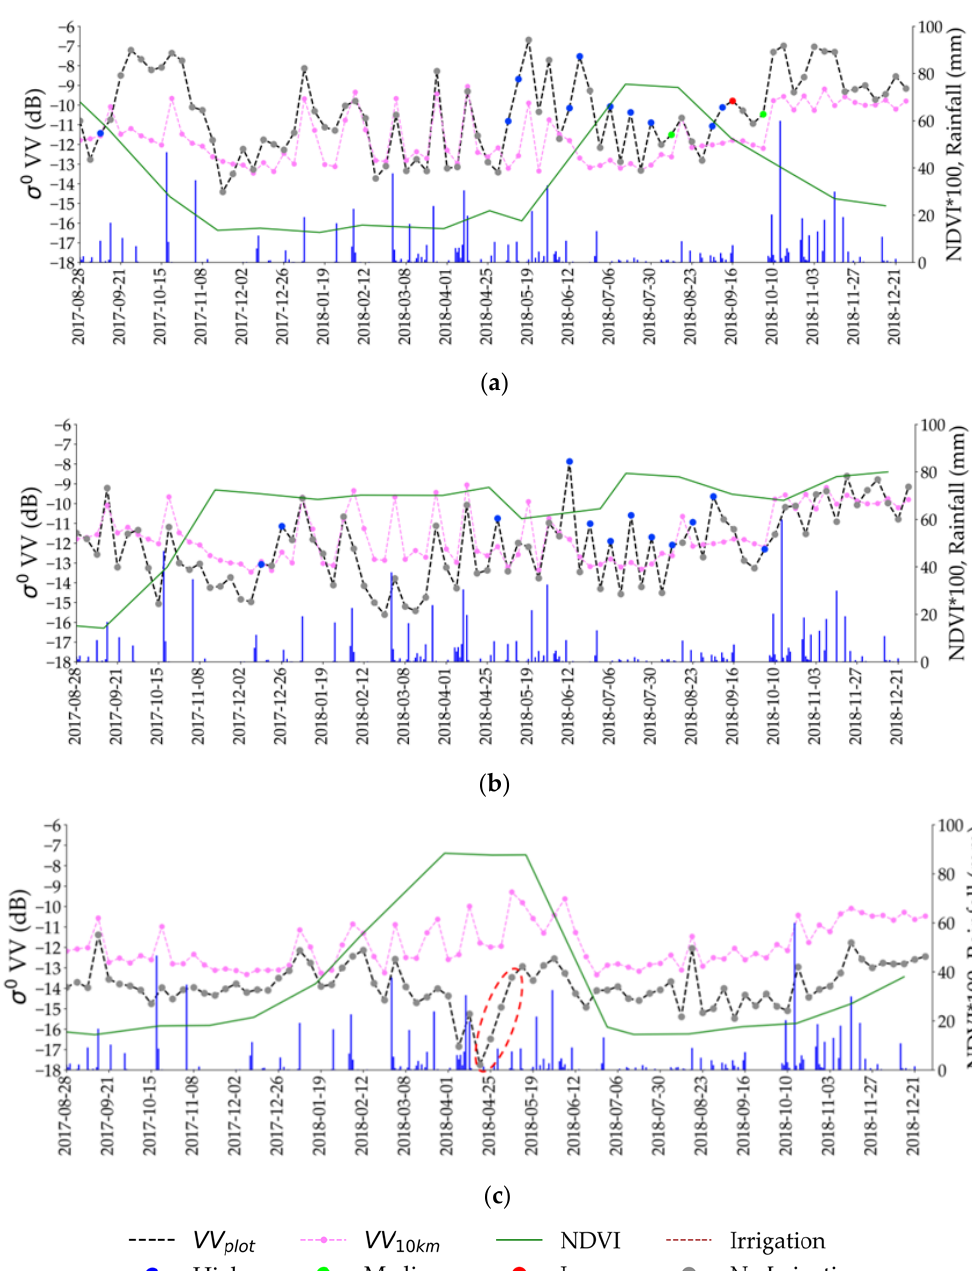
Figure 7. Irrigation detection over agricultural plots in Catalonia, Spain for ( a ) irrigated maize plot, ( b ) irrigated alfalfa plot, and ( c ) non-irrigated wheat plot. The red dashed ellipse represents the period of the transition between the heading and soft dough phase of the wheat plot.